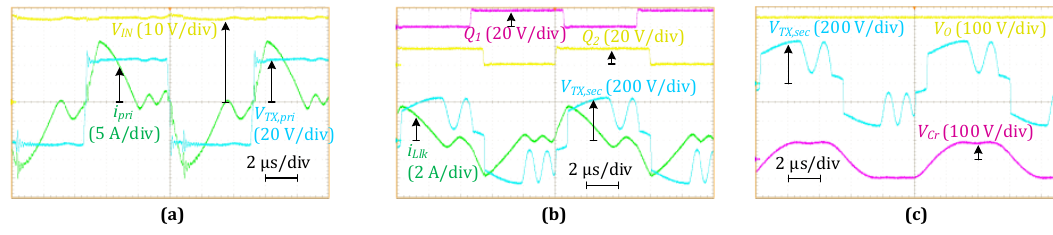
Figure 12. Waveforms of the studied topology with the overlapping PWM at P IN = 300 W and V IN = 45 V: ( a ) front-end inverter; ( b ) bridgeless rectifier; ( c ) output and resonant capacitor voltage.